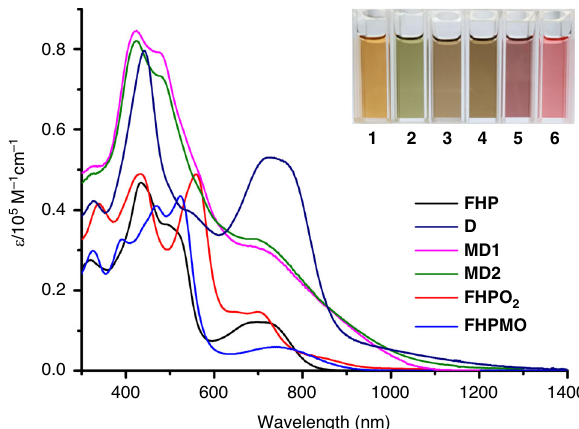
Fig. 4 UV/vis/NIR absorption spectra of the dimers and monomers considered in this study as recorded in CH 2 Cl 2 . The inset shows photographs of the corresponding solutions in CH 2 Cl 2 (1.0 × 10 − 5 M for all compounds). Here the numbers 1 – 6 refer to FHP , D , MD1 , MD2 , FHPO 2 , and FHPMO ,